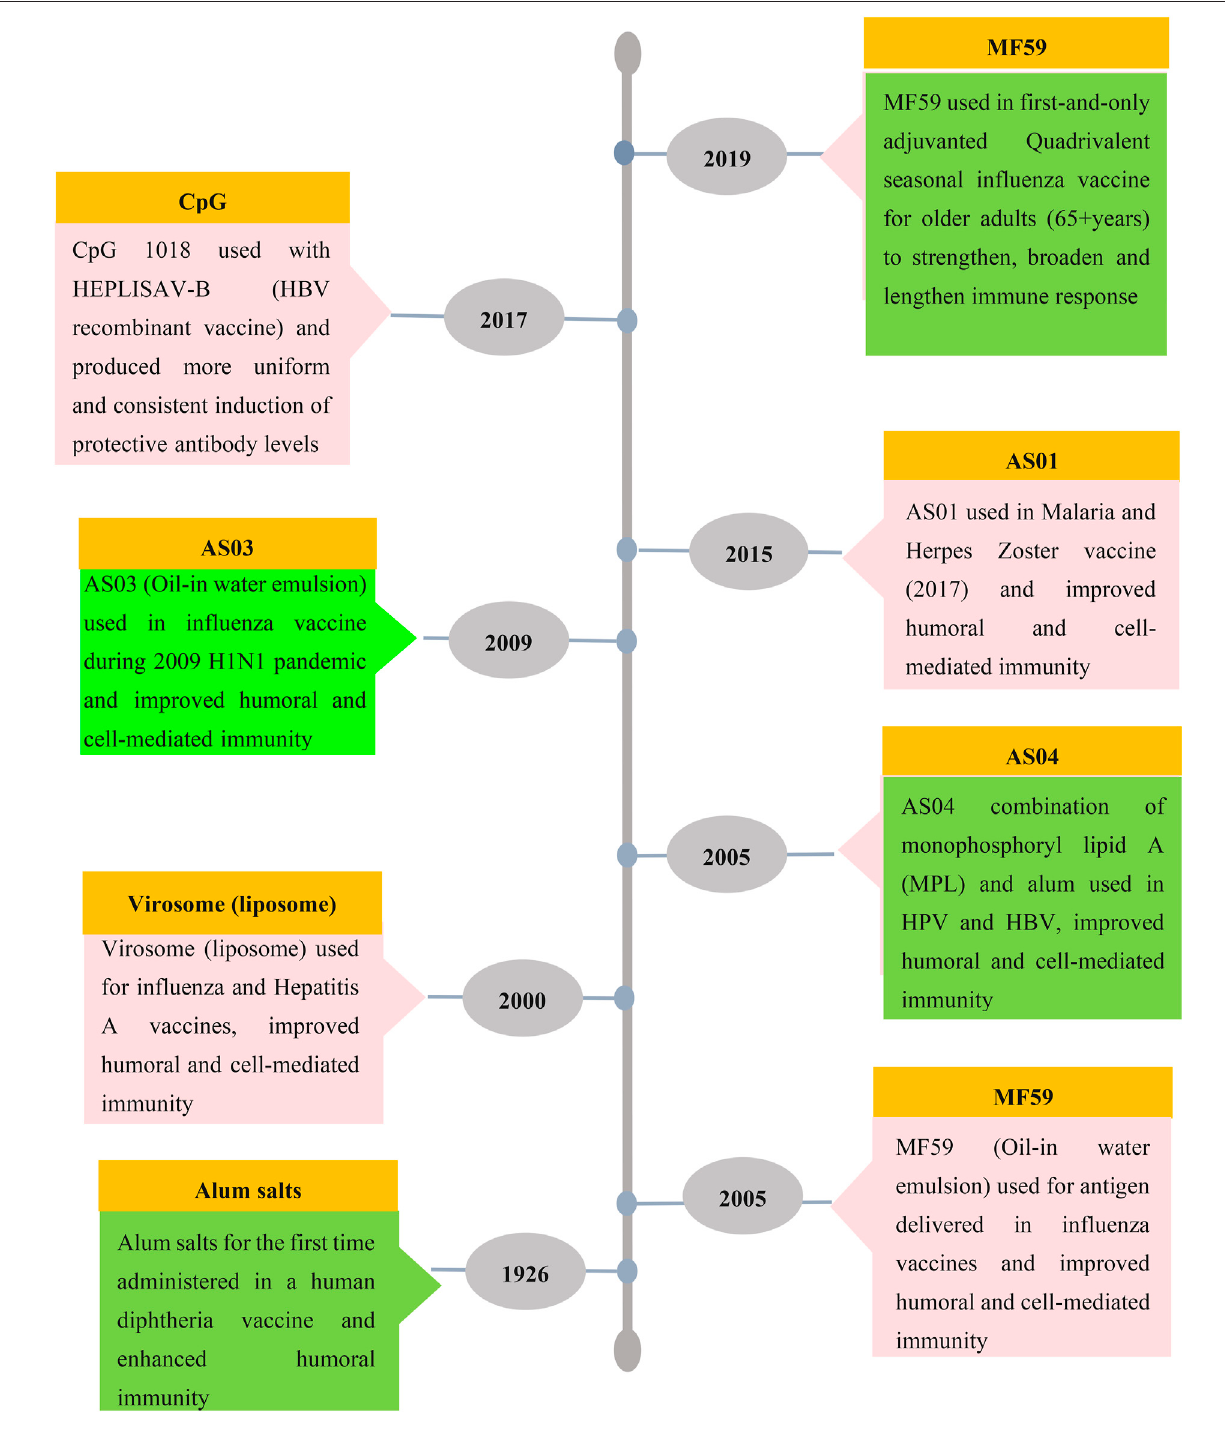
Frontiers in Pharmacology |